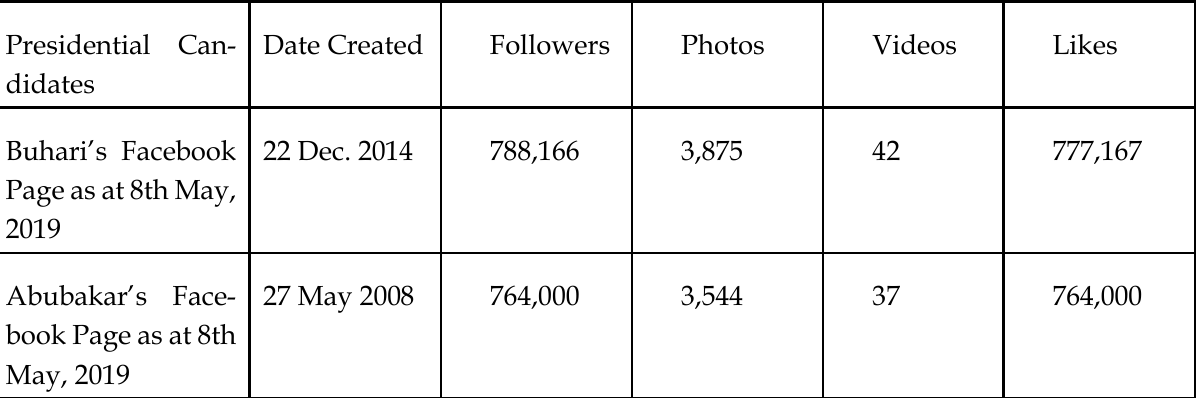
Table 1: Detailed analysis of content manifest as at February 2019